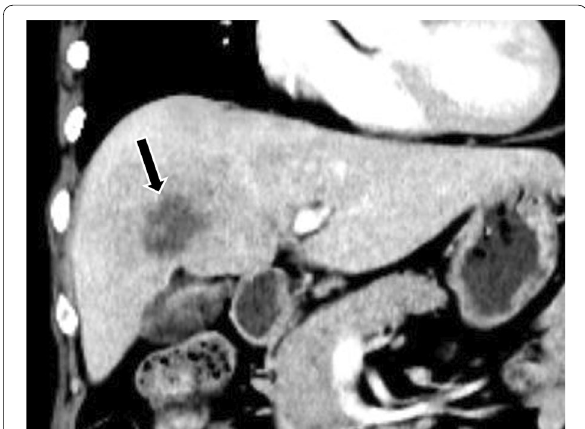
Fig. 3 Typical mass-forming appearance of metastatic ILC in the liver in a 62-year-old female. She had Stage 1B ILC treated 4 years ago and was on adjuvant exemestane. Coronal contrast-enhanced CT image in the liver window shows a dominant hypodense mass in the liver (arrow) along with multiple other hepatic nodules (not pictured). Percutaneous biopsy of the liver mass showed metastatic